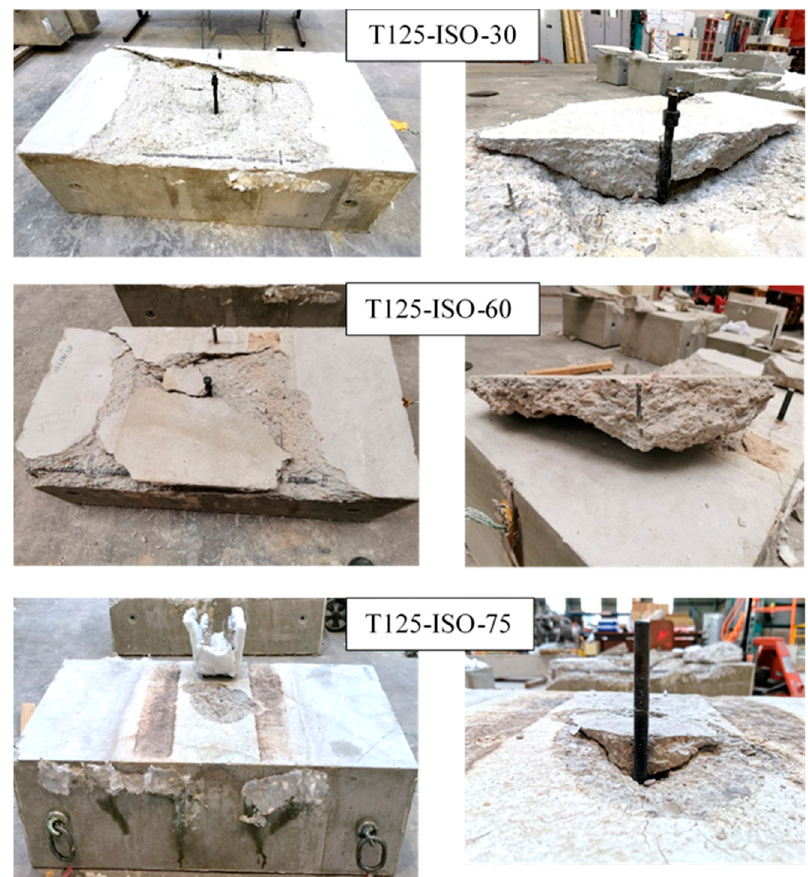
Figure 8. Crack patterns in slow-rate heating tests.